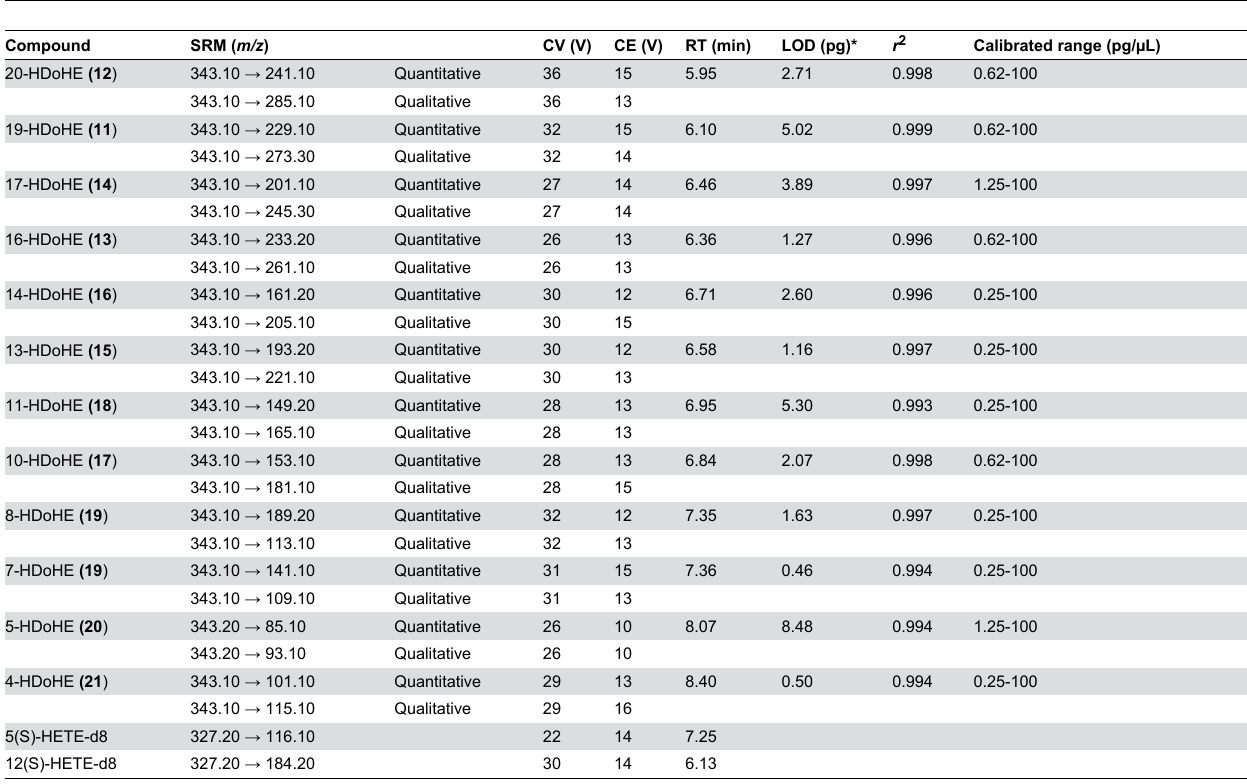
Numbers in bold correspond to the peak visualized in the LC-MS analysis (Figure 2). * on column Optimized mass transitions ( m/z ), cone voltage (CV), collision energy (CE), retention time (RT), limit of detection (LOD) and linearity ( r 2